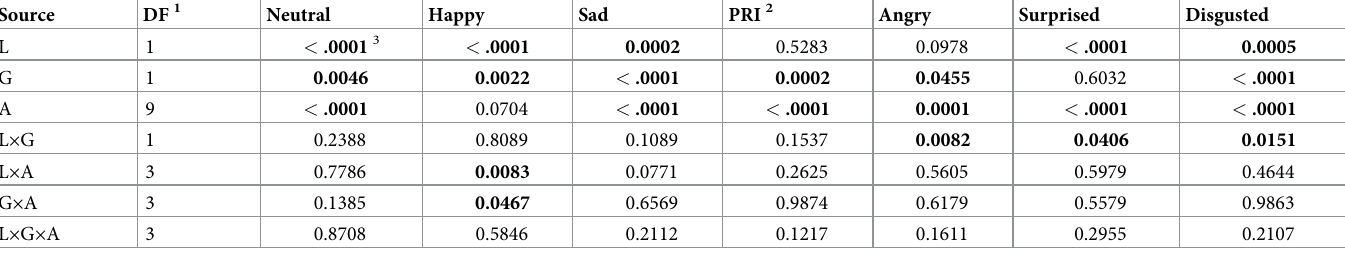
Table 3. P values from analysis of variance (ANOVA) of location (L), gender (G), age (A), and their interactions on ranked scores of neutral, happy, sad, angry, sur- prised, and disgusted expressions.